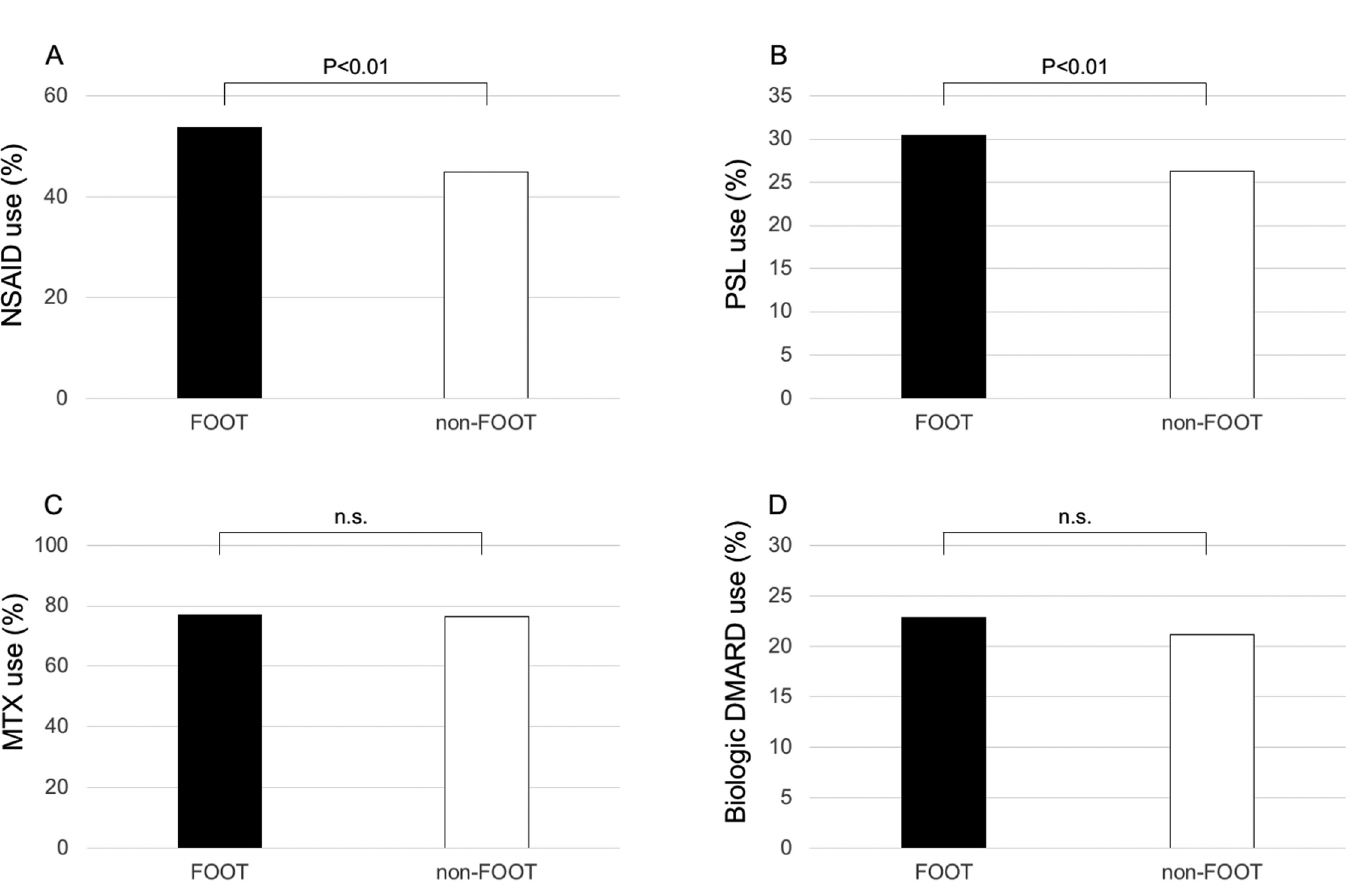
Fig 2. Bar graph showing the comparison of the use of drugs between the FOOT and non-FOOT groups. A, the use of nonsteroidal anti-inflammatory drugs (NSAIDs). B, the use of prednisolone (PSL). C, the use of methotrexate (MTX). D, the use of biological disease-modifying antirheumatic drugs (DMARDs). n.s. = not